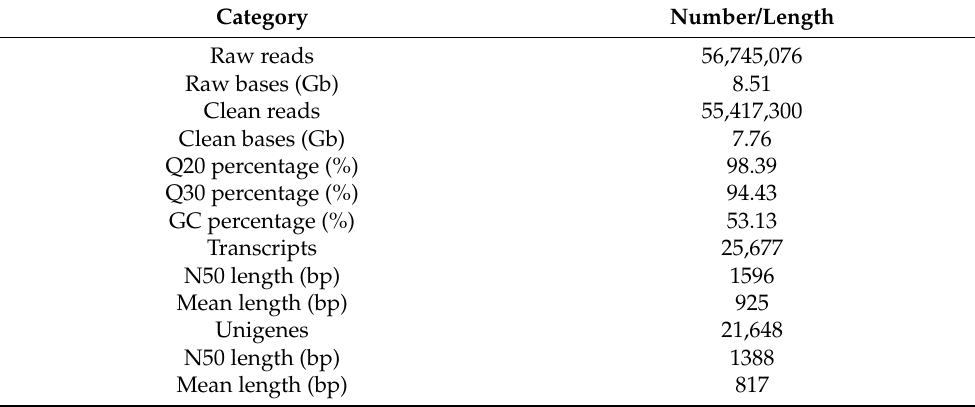
Table 1. Summary of sequencing data.